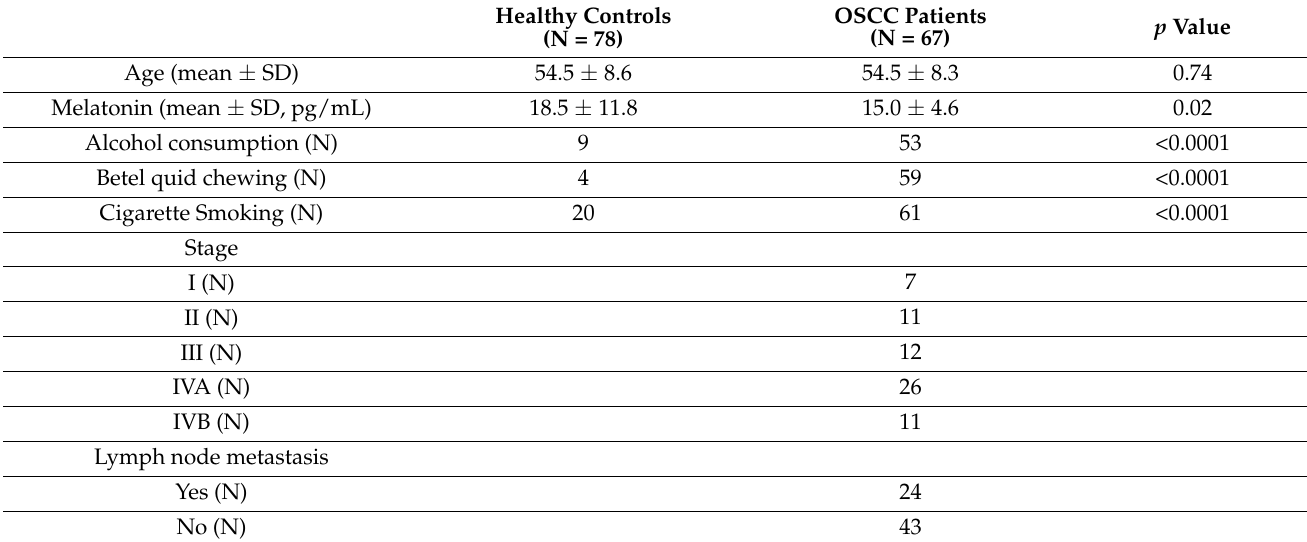
Table 1. Baseline characteristics in healthy controls and OSCC